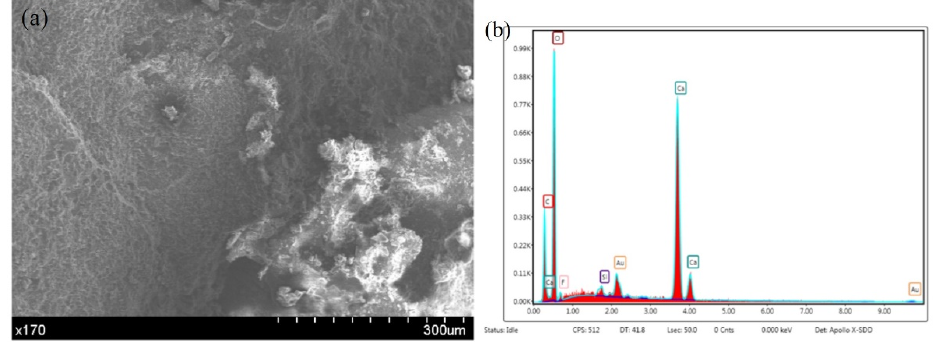
Figure 10. Microstructure and EDS results of the sample after healing. ( a ) Micromorphology. ( b ) EDS results.